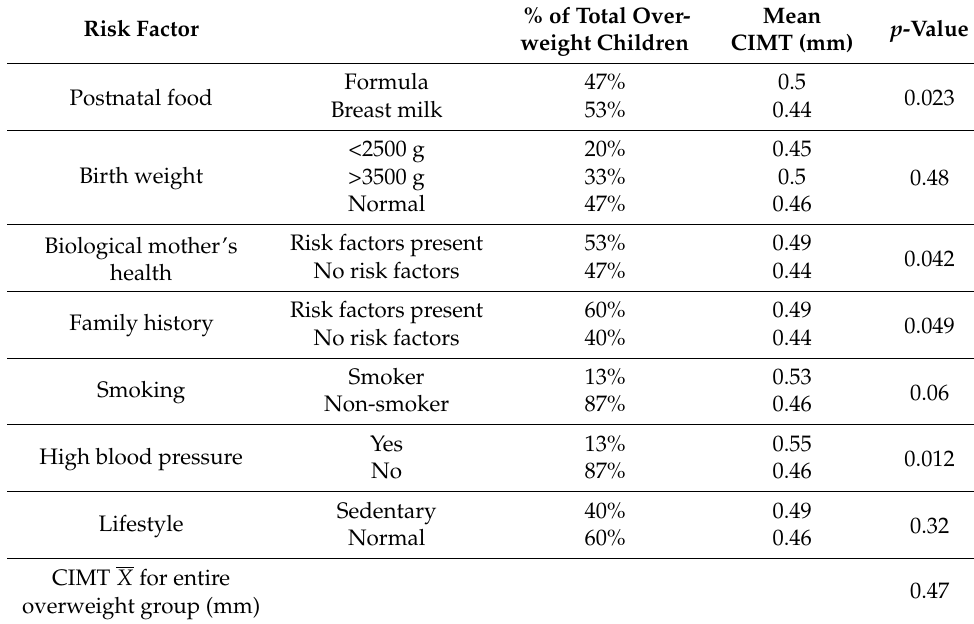
Table 4. Mean CIMT in the presence of different risk factors in overweight children.